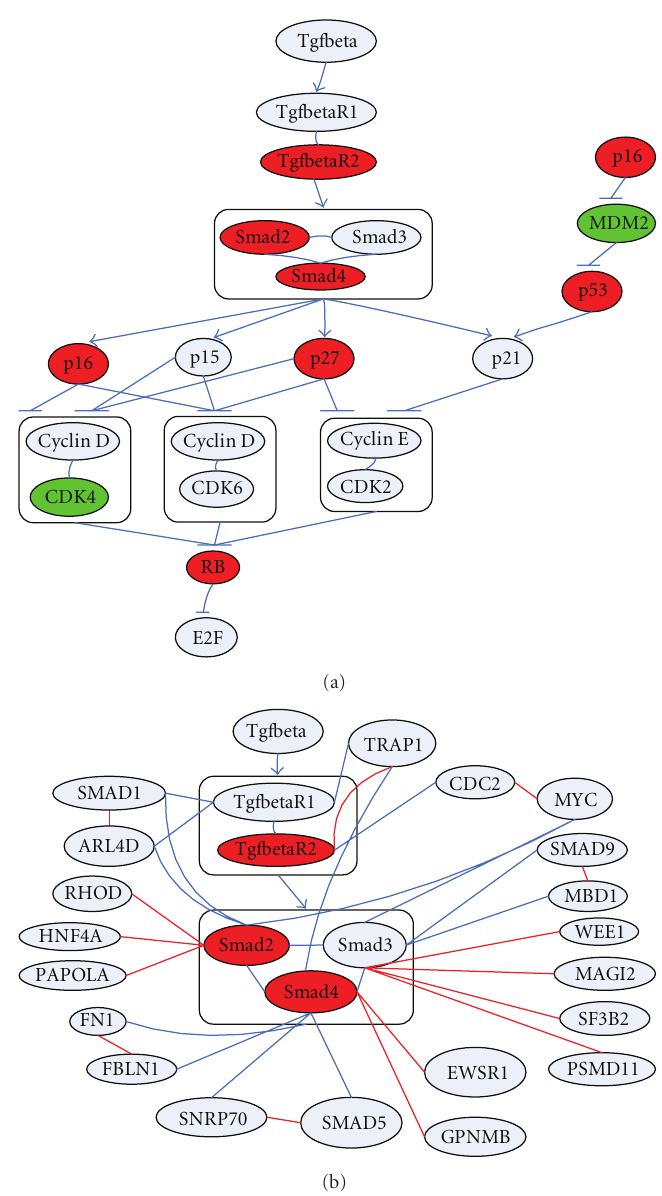
Figure 1: Antigrowth signaling pathway and cluster around SMAD proteins. (a) Antigrowth signaling pathway. Nodes and edges represent human proteins and protein-protein interactions, respectively. Edges with direction represent a regulatory relation. → means an activating relation and, (cid:7) means an inhibitory relation. (b) Cluster around smads. Red edges represent di ff erentially changed relations. Blue edges represent unchanged relations. Red nodes represent tumor suppressor genes, and green nodes represent